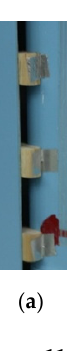
Figure 11. Injections of DCFJ312 airfoils with various OF s ( a ) OF = 1/3; ( b ) OF = 1/2; ( c ) OF = 2/3.